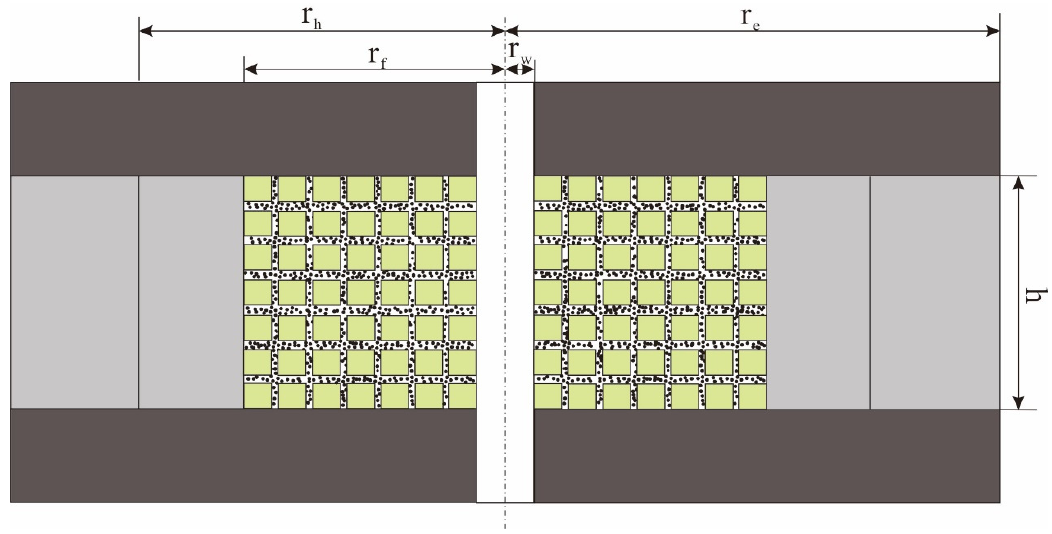
Figure 1. Thermal recovery model after formation fracturing and packing.